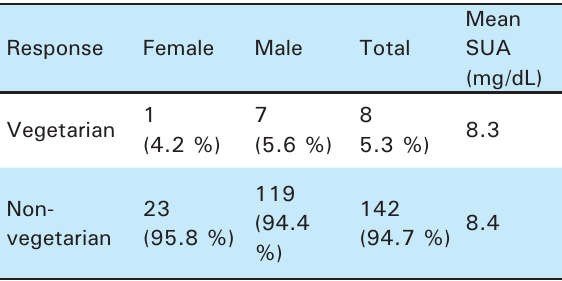
Table 3: Food habit and serum uric acid